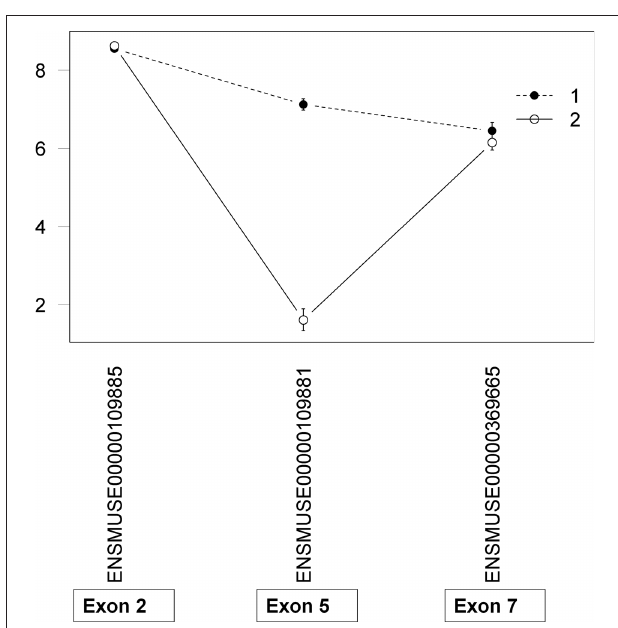
FiguRe 5 | Assessment of putative Aeus for cryptic SNPs. The probe index is simply the number of probes remaining in the probeset after the application of the SNP mask. In this example, there was a known SNP in Exon 5 of Psmb6 , which was found in three of the four probes within the probeset. The single remaining probe showed the maximal exon usage difference between strains which in turn led to a significant exon x strain interaction. Sequencing revealed an unknown SNP (cryptic) within the probe.